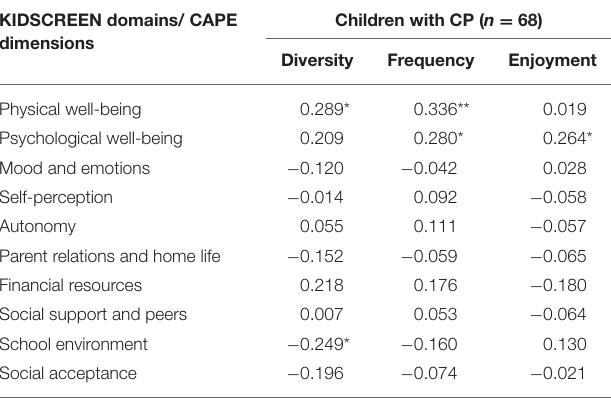
TABLE 4 | Correlation coefficients between CAPE and KIDSCREEN-52 domains.